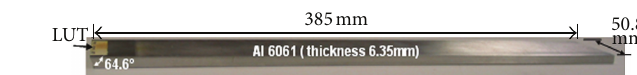
Figure 16: Integrated longitudinal wave ultrasound transducer (LUT) for the generation and detection of antisymmetrical PAWs using mode